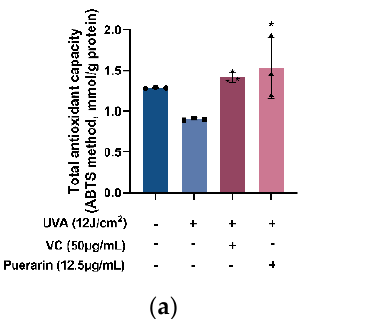
Figure 1. Effects of puerarin on UVA ‐ induced cytotoxicity in human skin fibroblasts (HSF): ( a ) Tox ‐ icity of different concentrations of puerarin on HSF; ( b ) Toxicity of different doses of UVA on HSF; ( c ) Preventative effects of puerarin on cytotoxicity in UVA ‐ irradiated HSF. ## p < 0.01, ### p < 0.001 as compared to the control group; *** p < 0.001 as compared to the damage model group; Values do not have a common mark ( # , *) when p > 0.05, ( n = 3).